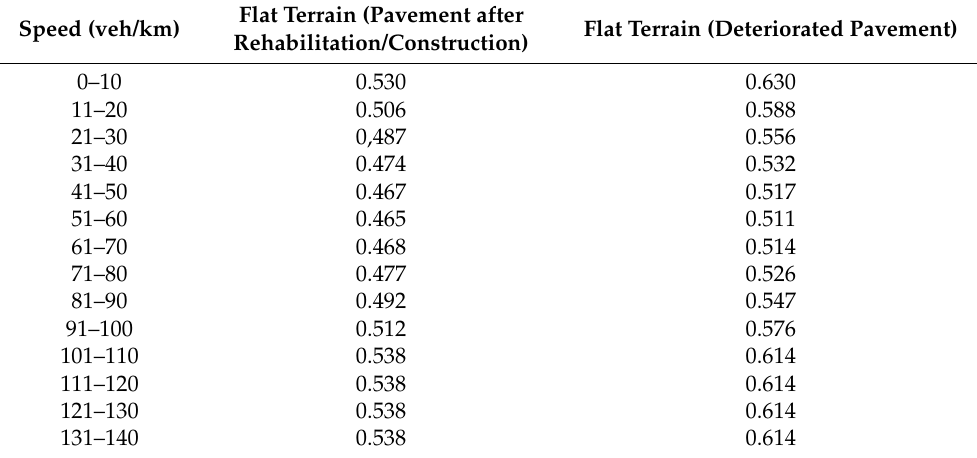
Table A4. Unit truck operating costs (EUR/veh km), prices 2019. Speed (veh/km)